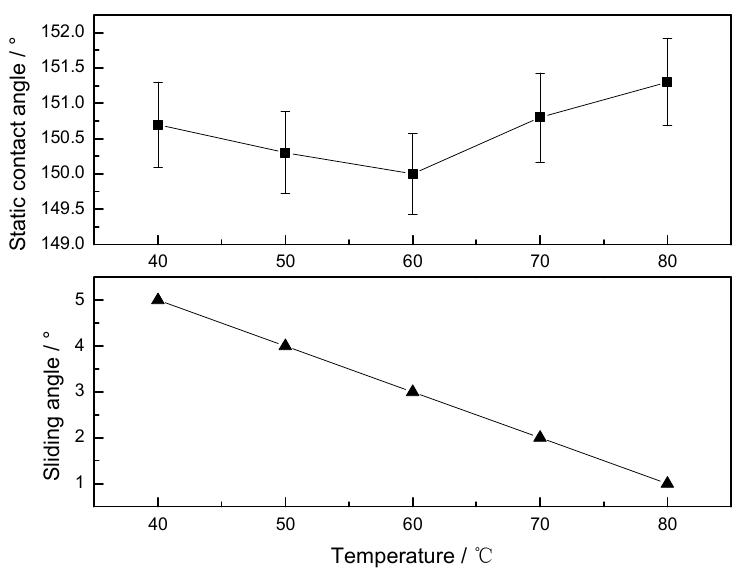
Figure 2. Variations of SCAs, SAs with solution temperature.